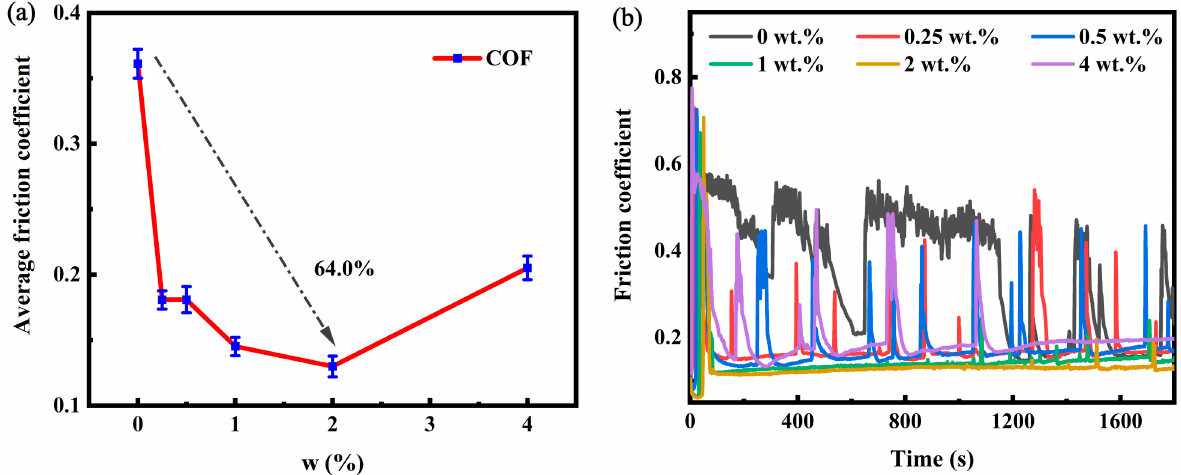
Figure 7. The ( a ) COF and ( b ) friction coefficient curves of frequency ramp-up reciprocation with the JD2000 concentrations ranging 0–4 wt.% on the aluminum plates.